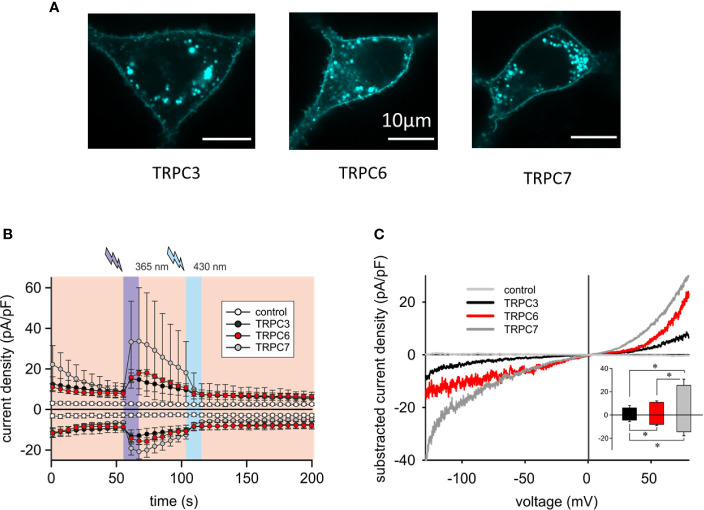
Overexpressed TRPC3/6/7 proteins are targeted to the plasma membrane of RBL-2H3 cells and generate cation conductances with divergent efficiency. (A) Representative epifluorescence images of RBL-2H3 cells expressing CFP-TRPC3 (n = 57), CFP-TRPC6 (n = 26) and TRPC7-CFP (n = 45), respectively. Scale bar = 10 µm. (B) Time courses of control (sham transfected, white, n = 6 cells), YFP-TRPC3 (black, n = 6 cells), YFP-TRPC6 (red, n = 8 cells) and TRPC7-CFP (grey, n = 8 cells) conductances recorded at −90 to +70 mV during repetitive photoconversion of OptoBI-1. Light illumination cycling is indicated as violet (365 nm) and blue (430 nm). (C) Representative net I–V relations (Imax − Ibasal) of OptoBI-1 induced currents in YFP-TRPC3 (black), YFP-TRPC6 (red), TRPC7-CFP (dark grey) transfected RBL-2H3 cells applying voltage-ramp protocols. Insert: Current density of net, maximum responses obtained at −90 to +70 mV (mean ± SEM). Statistical significance was tested by two tailed t-test (normally distributed values) or Mann–Whitney tests (non-normally distributed values), *p < 0.05, if not indicated differences are not significant (p > 0.05).